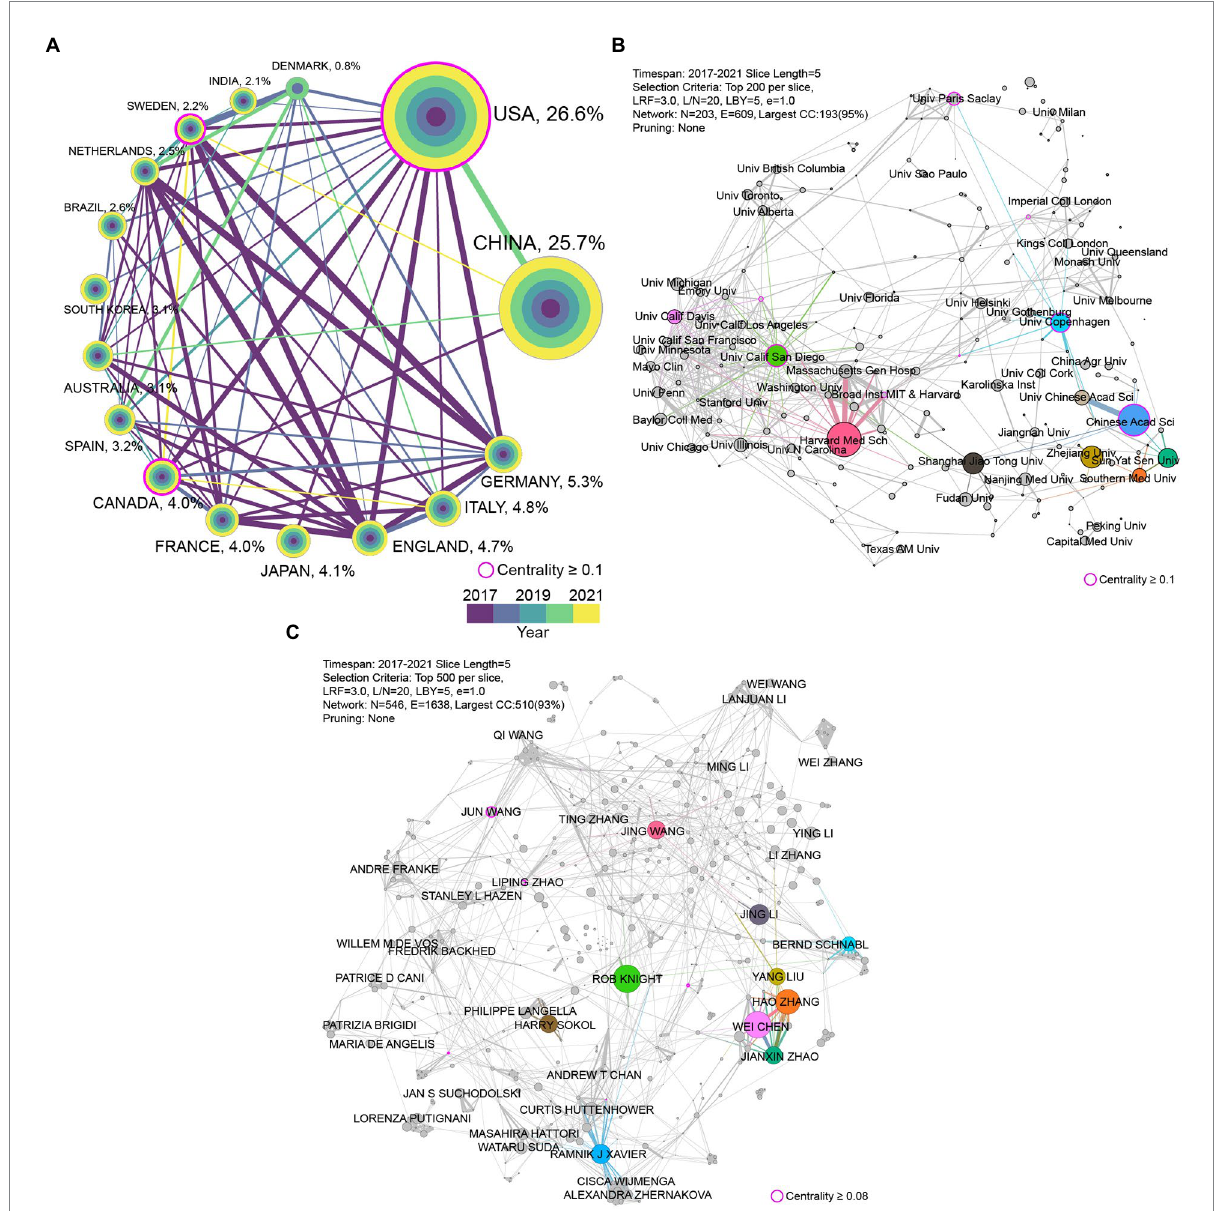
FIGURE 5 The cooperation network in different levels from 2017 to 2021. (A) The cooperation network of the top 15 most productive countries. The colored rings in the node represent publications amount in different years. The lines’ thickness and color indicate the strength of cooperation relationships and the year of first cooperation, respectively. (B) The largest component of cooperation network of institutions. The top 10 institutions in the number of publications are colored. (C) The largest component of author cooperation network. The top 10 authors in the number of publications are colored. The nodes’ size and the thickness of the lines positively correlated to the production of papers and the strength of cooperation relationships,